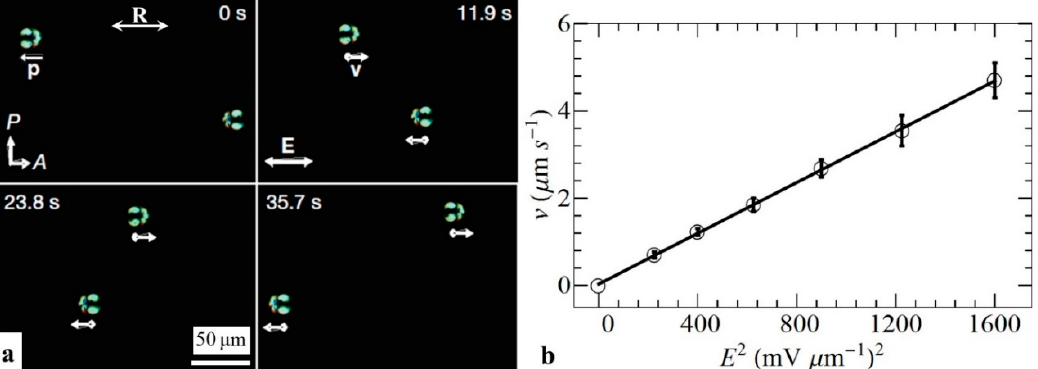
Figure 3. Nonlinear liquid crystal-enabled electrophoresis (LCEP) of two glass spheres powered by an alternating current (AC) electric field demonstrated by Lavrentovich et al. [34]. ( a ) Time sequence of polarizing microscope textures of two colloidal spheres, moving in opposite directions defined by the orientation of the structural dipole p ; R represents the rubbing direction which sets the uniform alignment of liquid crystal (LC); ( b ) Quadratic dependence of spheres velocity on the amplitude of the AC electric field. Adapted with permission from Ref. [34].